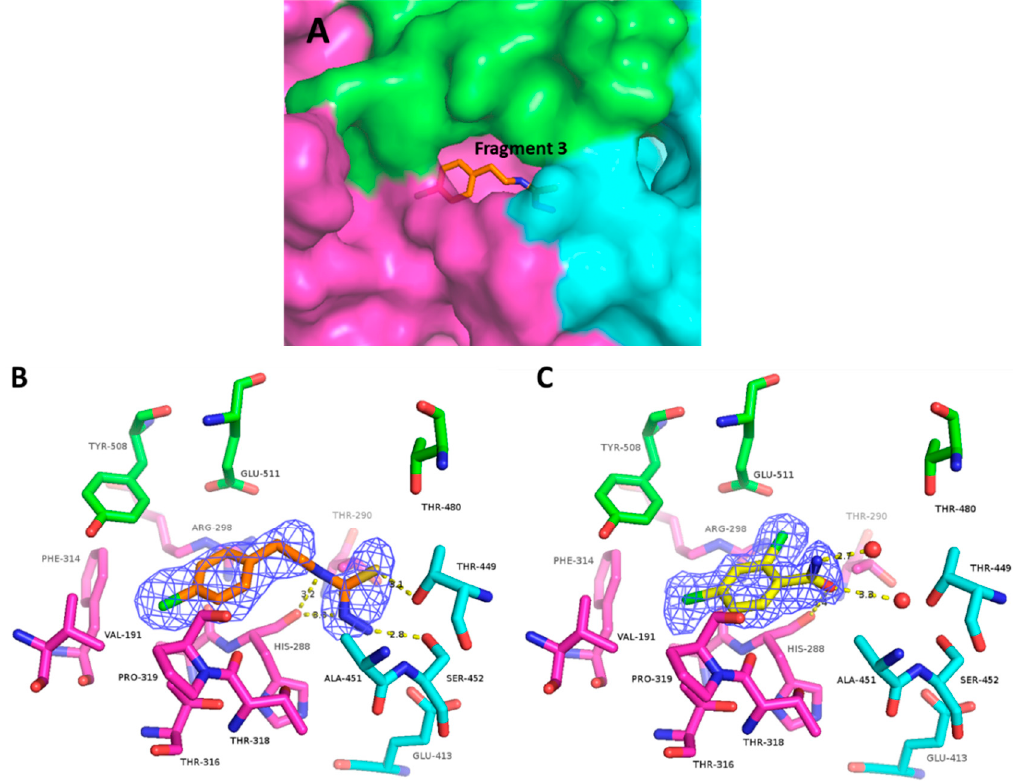
Figure 3. Fragment-binding site B. ( A ) Overall view of the binding pocket with fragment 3 in place. Coloring for the three helicase domains is the same as in Figure 1. ( B ) Electron density map and H-bonds made by fragment 3 . Residue Pro320 locates in this view on top of the fragment, and has been omitted for clarity. ( C ) Electron density and H-bonds made by fragment 4 . Residue Pro320 has been omitted for clarity.